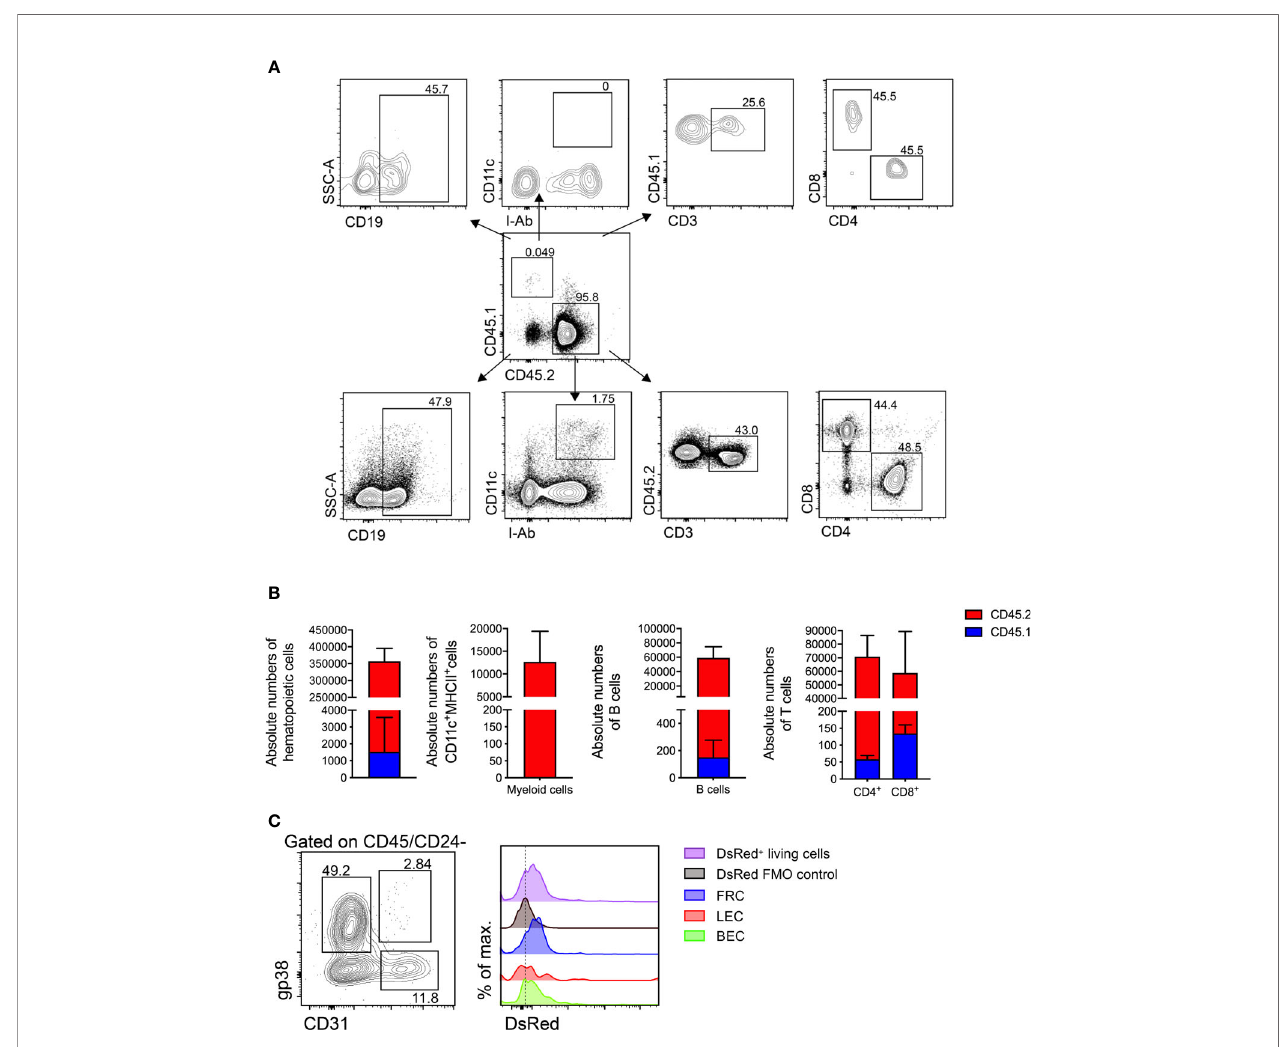
FIGURE 4 | Donor mLNs are repopulated with recipient hematopoietic cells after surgical transplantation. (A) Flow cytometry gating of hematopoietic cells in mLNs from B6.CD45.1 mouse transplanted in a B6.CD45.2 mouse. (B) Absolute numbers of hematopoietic cells, myeloid cell (dendritic cells and macrophages), B cells and CD3 + pre-gated CD4 + and CD8 + T cells in CD45.1 + and CD45.2 + sub-populations, 5 weeks after mLN transplantation. Data pooled from fi ve mice analyzed in two experiments. (C) Flow cytometry gating of non-hematopoietic LNSCs and DsRed fl uorescence signal from B6.DsRed mLNs transplanted in a B6.WT mouse, with DsRed + living cells from a DsRed + mouse as positive and living cells from a WT mouse serving as negative controls. Analysis performed 5 weeks after mLN transplantation. Error bars represent Mean±